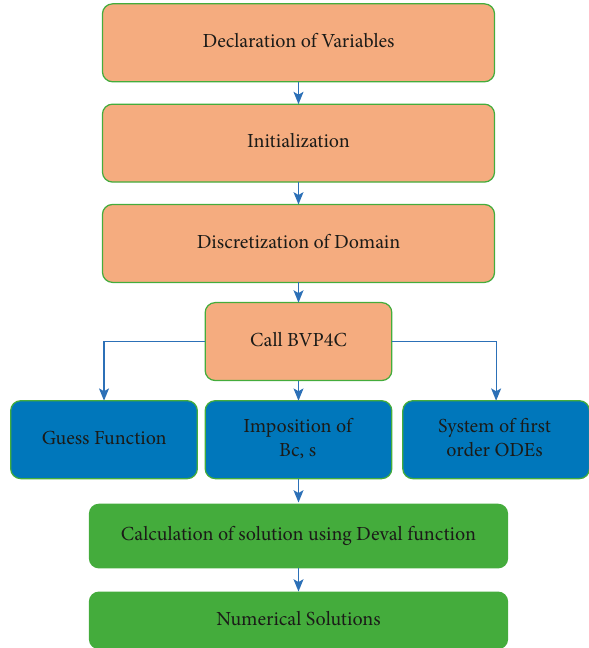
Figure 2: Flowchart of the